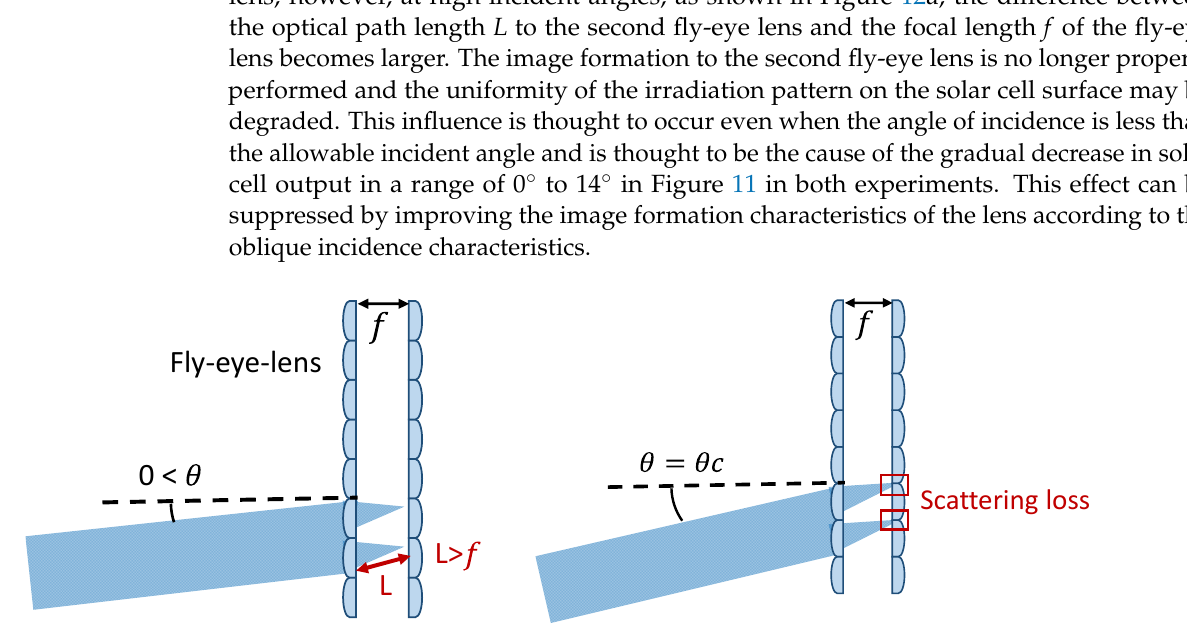
Table 1. Comparison of light ‐ receiving module.